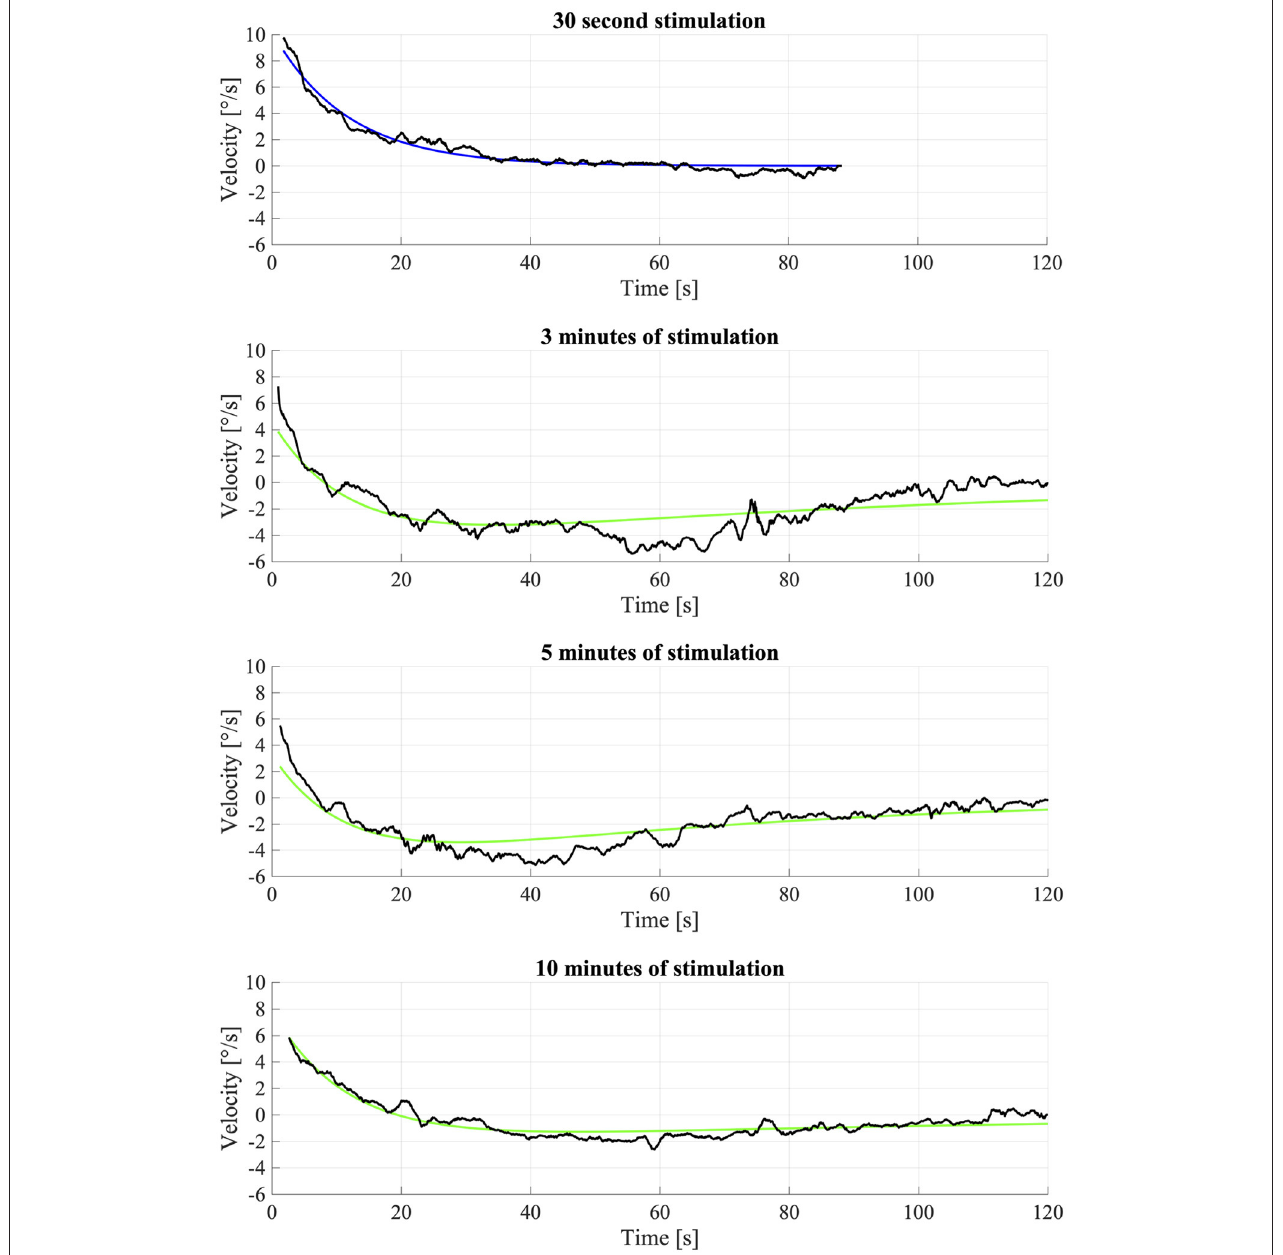
FIGURE 3 | Fitting of OKAN-II S09. The fitting of the 30s condition was used for fixing the OKAN-I parameters for the other (3, 5, 10min) conditions and is therefore fitted with Equation (1). The longer conditions (3, 5, 10min) were fitted with Equation (2). Due to noise and inconsistency the fit wasn’t particularly